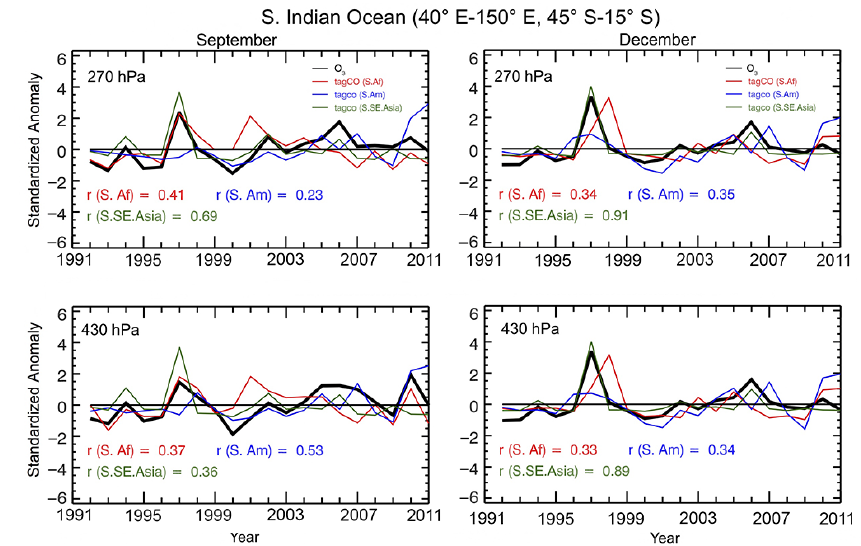
Figure 12. The standardized anomalies of the tagged CO tracers over the South Indian Ocean region from three burning source regions, including southern Africa (red), South America (blue), and South and Southeast Asia (green), and their comparison with the EmissO 3 (black) at 270 and 430hPa in September and December from 1992 to